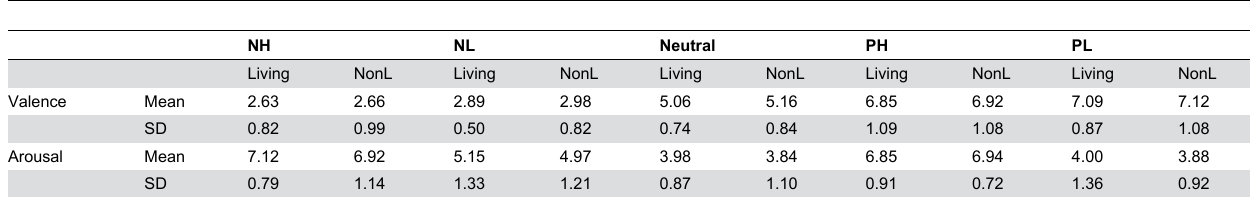
Table 1. Valence and arousal scores in Experiment